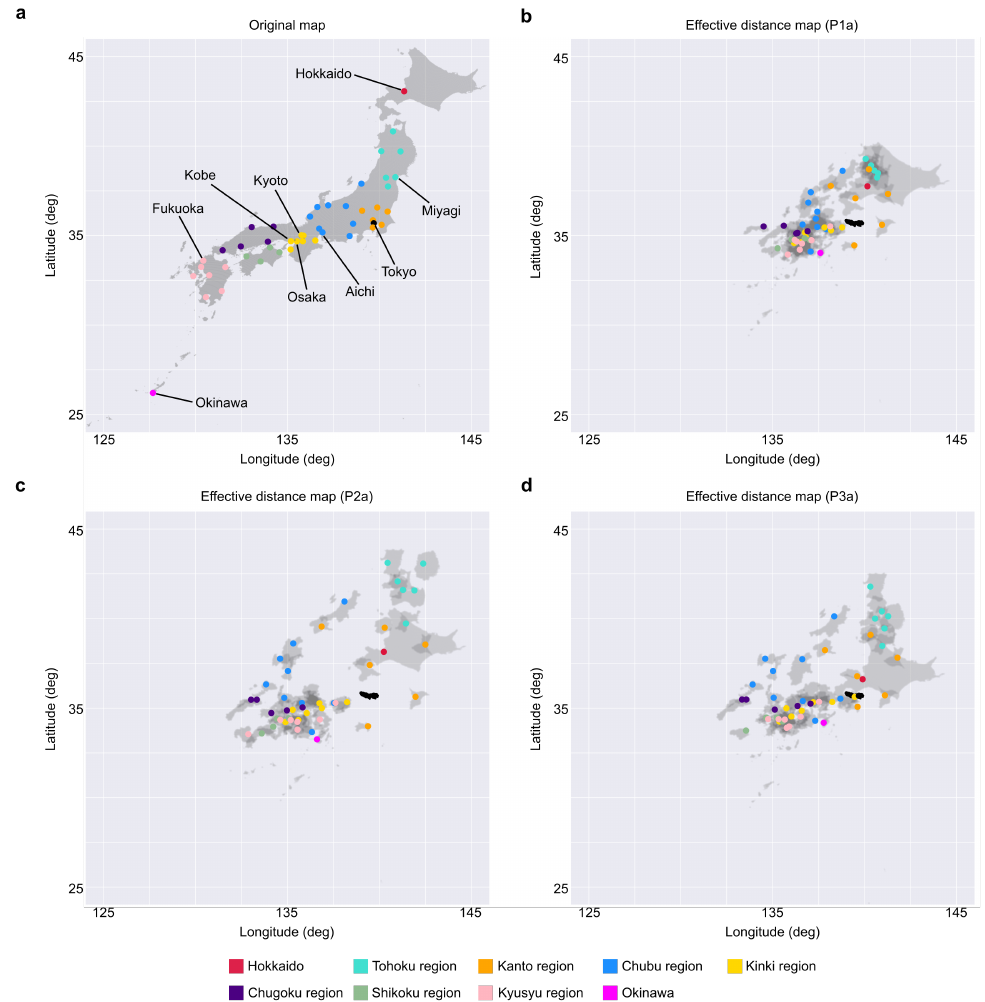
Figure 5. Distorted maps of Japan based on effective distance and local interactions reveal non- uniform spreading of the virus across Japan. ( a ) Original map of Japan. Each point indicates the capital of each prefecture, colored by region. ( b – d ) Distorted maps of Japan based on effective distance and local connectivity in periods P1a, P2a, and P3a (Figure